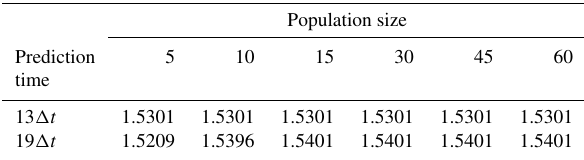
Table 4. Mean CFV of 40 CNOPs produced by PSO-CNOP for every given population size.